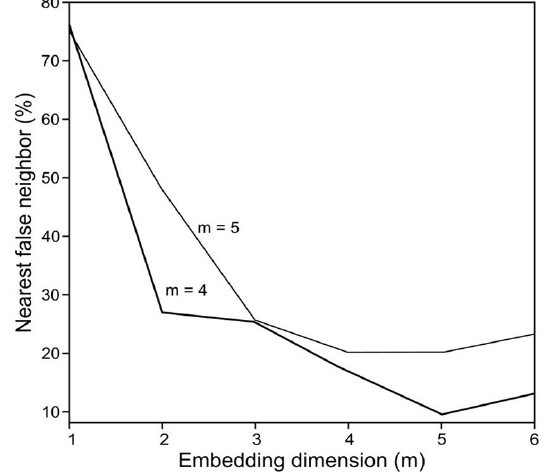
Figure 4. False close neighbors with a time lag of 10, where the em- bedding dimension of 5 has a 9.4% and the embedding dimension of 4 has a 16.66% false close neighbors (lower line). False close neighbors with a time lag of 9, where the embedding dimension of 5 has a 20.15% and the embedding dimension of 4 has a 20.12% false close neighbors (upper line). The values in each line indicate the optimal dimension for each